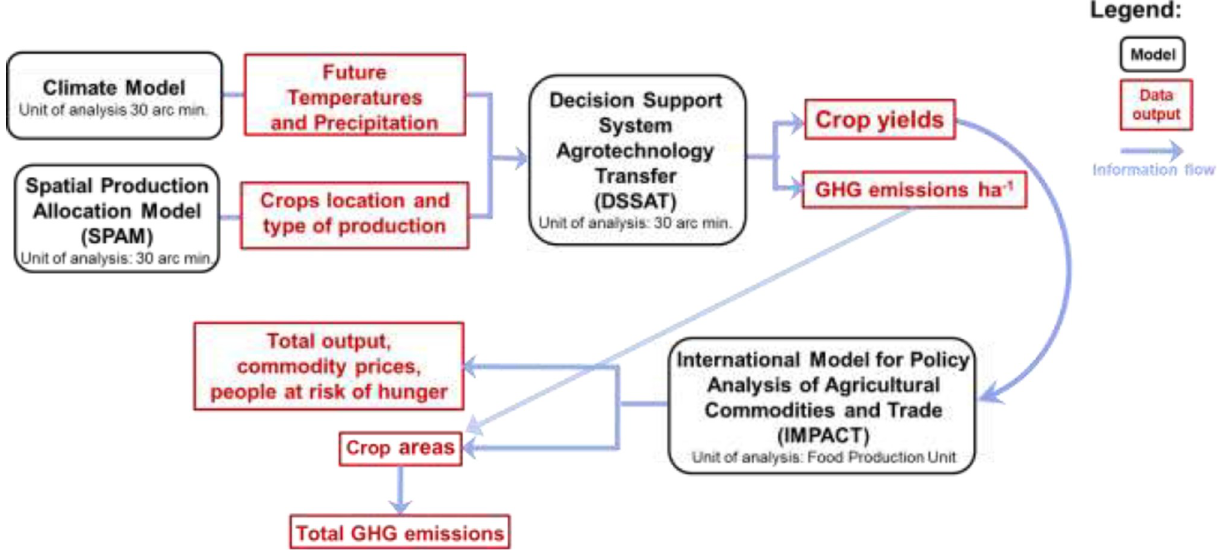
Fig 1. Scenario modeling steps and information flow. Source: Authors.